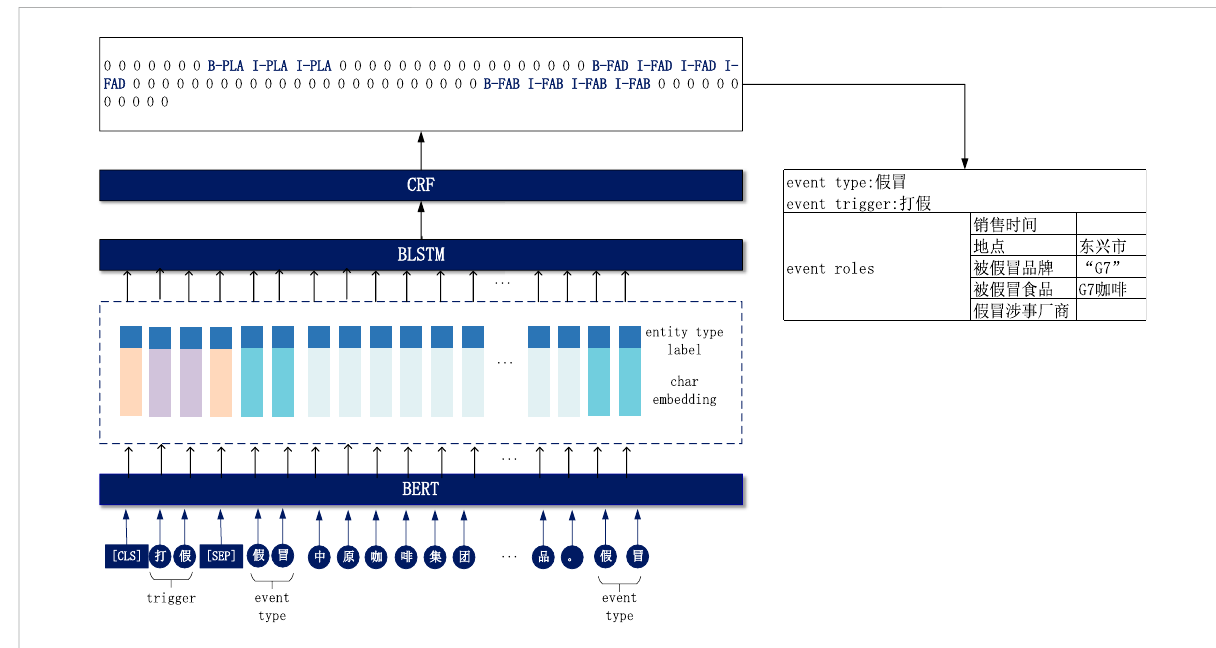
FIGURE 2 Structure diagram of the event argument extraction model. It illustrates the event argument extraction process for one